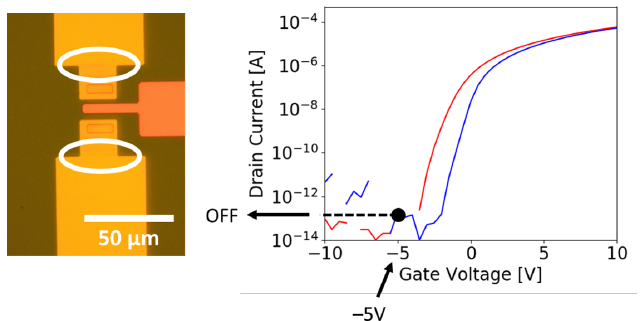
Figure 13: Microscope image and I d - V g graph of a transistor, corresponding to a laser configuration that does not change the state of the transistor when the gate voltage is -5 V. The blue line indicates the current before lasering. The red line indicates the current after lasering. The laser is configured to an attenuation of 35 dB in low energy mode; two pulses are applied (Setting